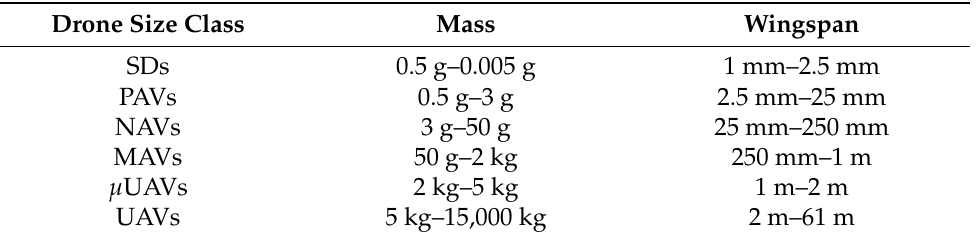
Table 1. Example of drone classifications based on mass and wingspan, from Smart Dust (SD) to Unmanned Air Vehicles (UAVs): PAVs, Pico Aerial Vehicles; NAVs, Nano Aerial Vehicles; MAVs, Micro Aerial Vehicles; µ UAVs, micro Unmanned Aerial